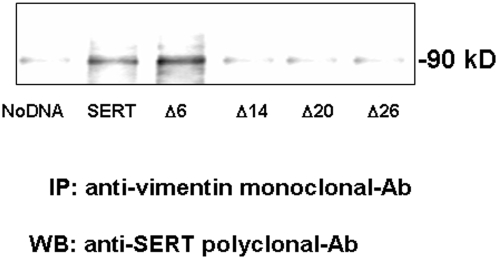
Vimentin binding domain on the C-terminus of SERT.CHO cells expressing the indicated SERT constructs were lysed and prepared for IP. The cell lysate was incubated with monoclonal anti vimentin-Ab coated protein A sepharose beads. The presence of SERT truncations was detected with a polyclonal SERT Ab (Chemicon International). Since SERT-Δ6 bound to vimentin and the other truncations, we proposed that the amino acids 616–624 are at least one of the vimentin binding domains on the C-terminus of SERT. Nonspecific adsorption of Sepharose beads was not determined in the absence of vimentin-Ab and the data obtained from this set of experiment is not presented here since it can be found in Figure 1B. All lanes contain protein recovered from the same number of cells equivalent to 30% of one well from a confluent 24-well culture plate. Figure shows representative images from 3 separate experiments.